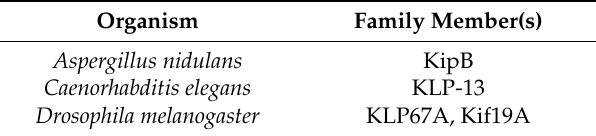
Table 1. Kinesin-8 family members in different